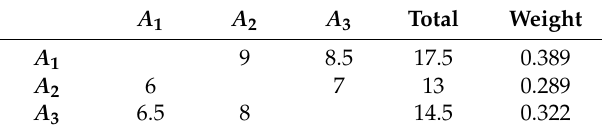
Table A11. Judgment matrix of A 1 – A 3